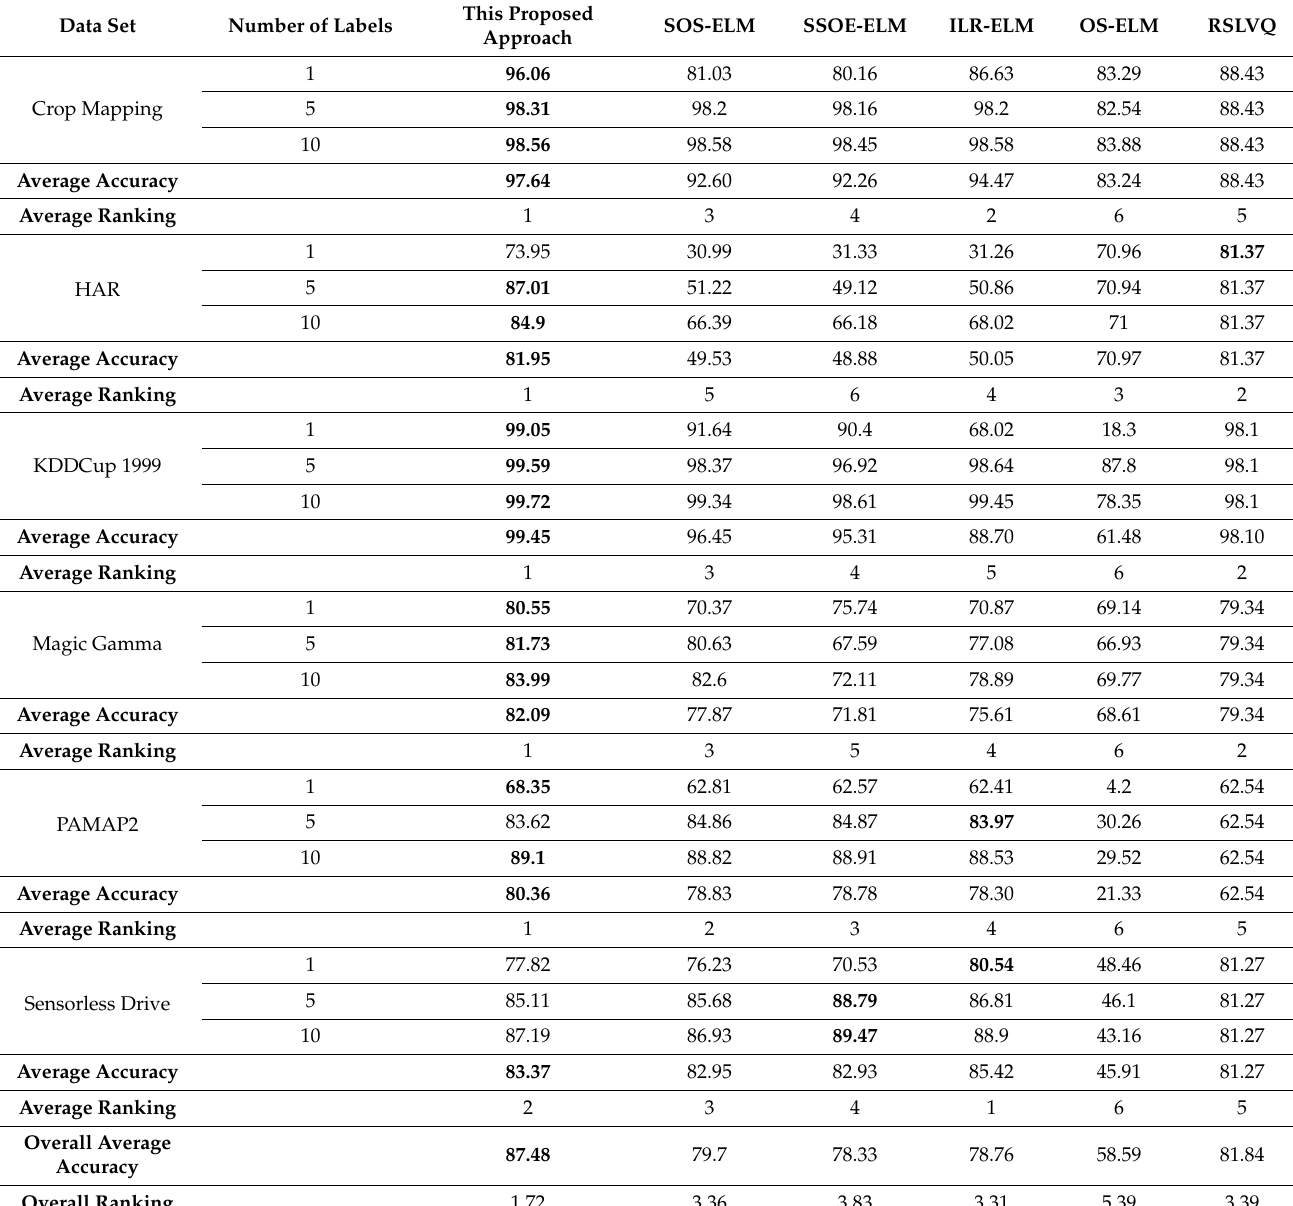
Table 3. Performance comparison of this approach compared with other related semi-supervised learning techniques and supervised learning